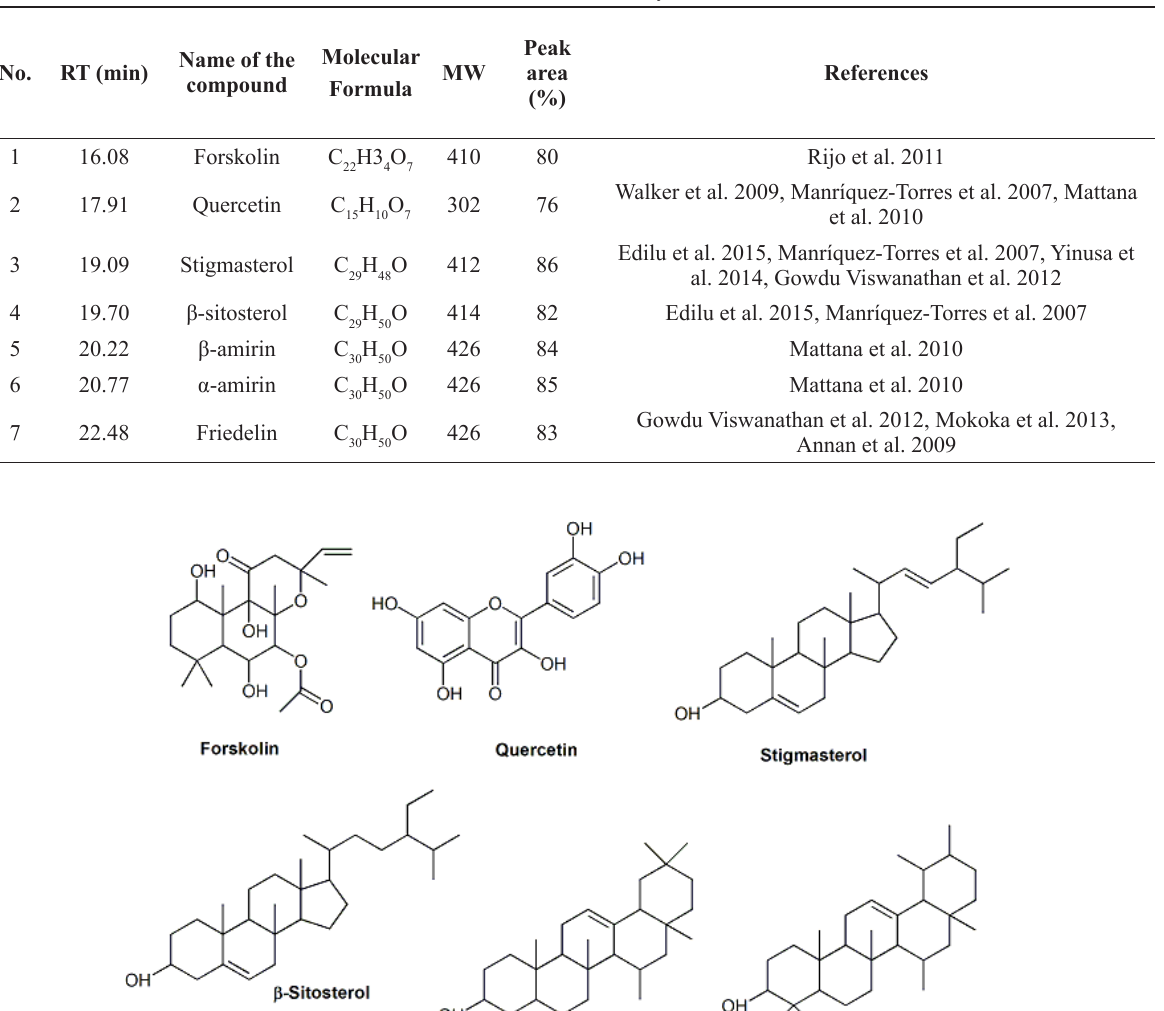
Main compounds identified by GC-MS in dichloromethane extract of P. ornatus leaves that present previously antibacterial activity.